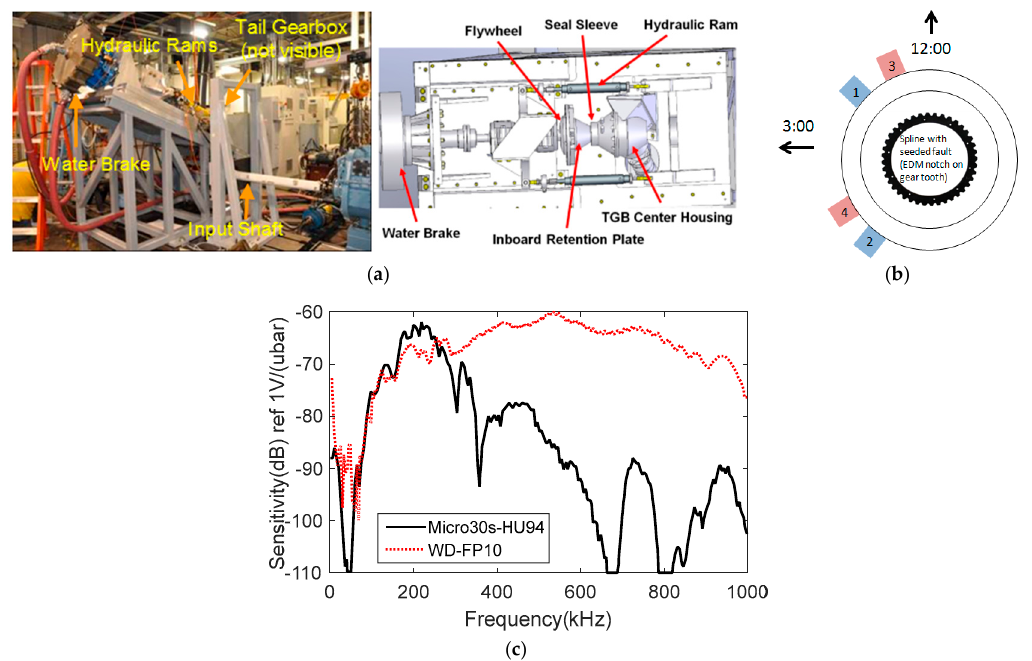
Figure 1. The Naval Air Systems Command (NAVAIR) gearbox test ( a ) the test rig, and ( b ) the types and positions of the AE sensors on the gearbox housing (CH (Channel) 1 and 2 are WD (wideband) sensors, and CH 3 and 4 are micro 30 sensors) ( c ) the sensitivity curves of Micro30s and WD sensor provided by Mistras Group Inc.